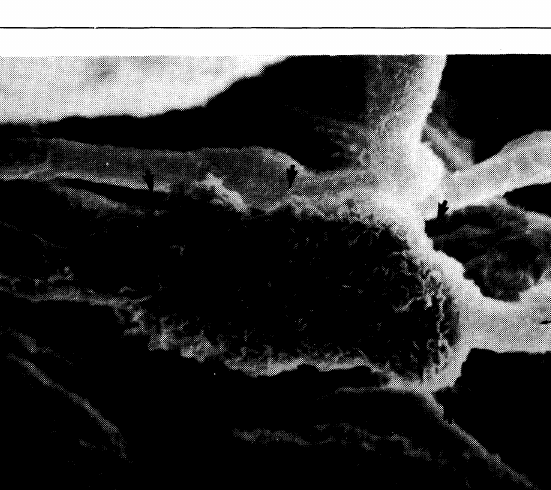
FIG. 5.90 after ZAP exposure. Some intravascular activated leucocytes form tight leucoaggregates within the vessels. Subsequently the surrounding endothelium is destroyed and the capillary flow